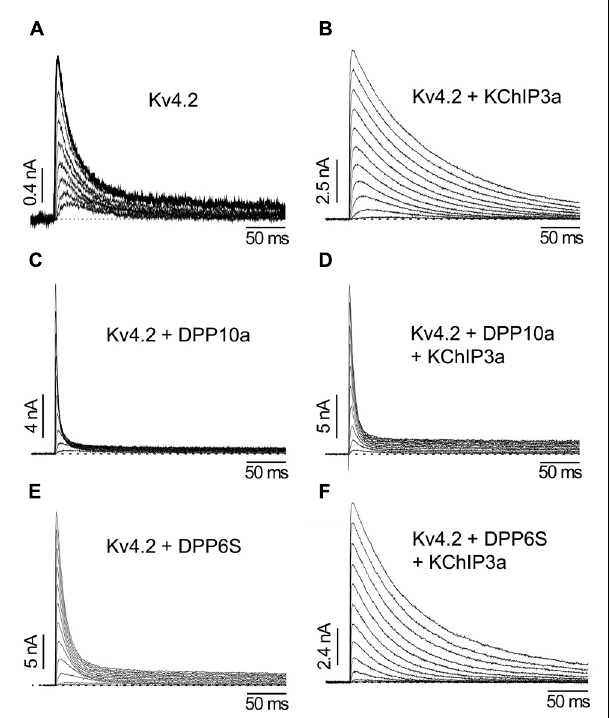
FIGURE 6 |The differential functional effects of DPLP N-terminal variants (Adapted from Jerng etal., 2005). (A) Kv4.2 outward currents elicited by membrane depolarization in CHO cells. (B) After co-expression with KChIP3a, Kv4.2 channels significantly increase in surface expression and exhibit slower inactivation. (C) Similar to KChIP3a, co-expression of Kv4.2 with DPP10a results in a dramatic increase in peak current; however, the inactivation kinetics is markedly accelerated. (D) Channel complexes co-expressing KChIP3a and DPP10a results in currents that are more like that of Kv4.2 + DPP10a channels, indicating the dominance of DPP10a-mediated fast inactivation. (E) DPP6-S accelerates inactivation of Kv4.2 channels. (F) Co-expression of DPP6-S with Kv4.2 + KChIP3a channels does not produce dramatic acceleration of inactivation observed with